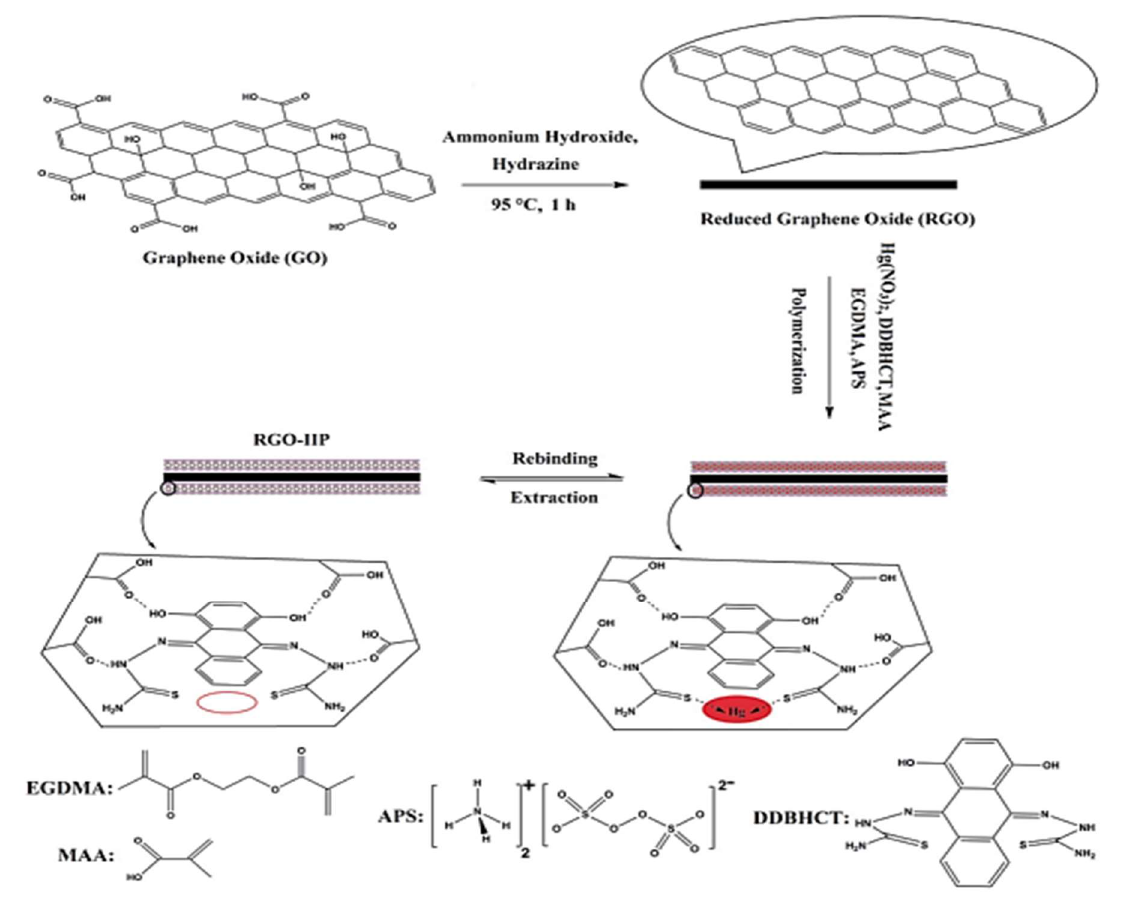
Figure 3. Preparation of reduced graphene oxide-ion-imprinted polymer modified glassy carbon electrode [46]. (Reproduced under permission from Elsevier, doi:10.1016/j.msec.2016.03.005).